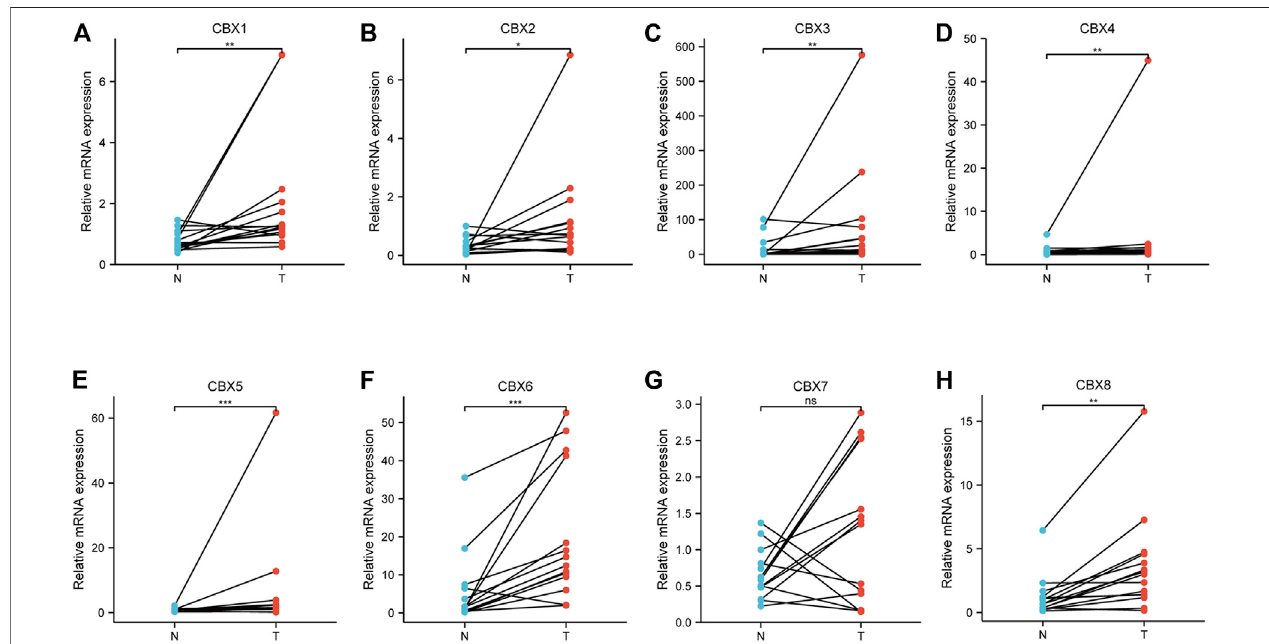
FIGURE 8 | Real-time qPCR validation of CBX family members in 17 ESCA and normal esophageal tissues (A – H) . * p < 0.05, ** p < 0.01, *** p < 0.001 analysis by paired t-test.